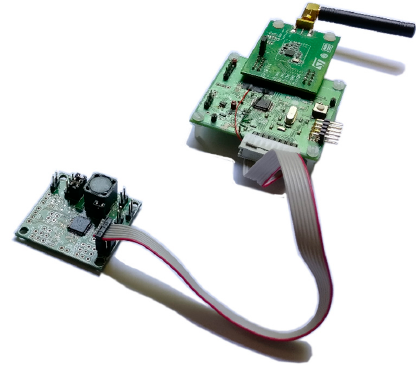
Figure 12. Sensing node and harvesting module boards.